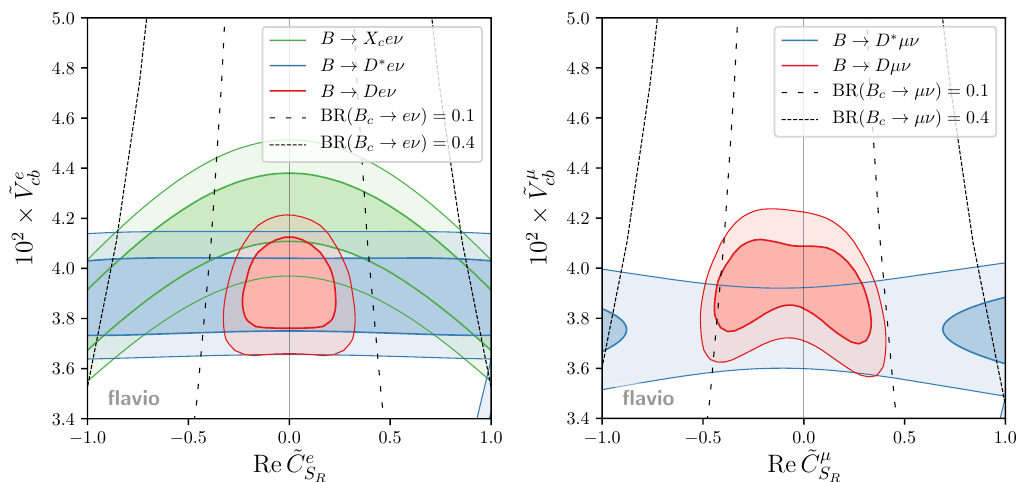
Figure 5 . Constraints on the scalar coe(cid:14)cients ~ C e;(cid:22) cient C V , from inclusive and exclusive decays as well as the total width of the B c meson, seperately L for electrons (left) and muons (right).